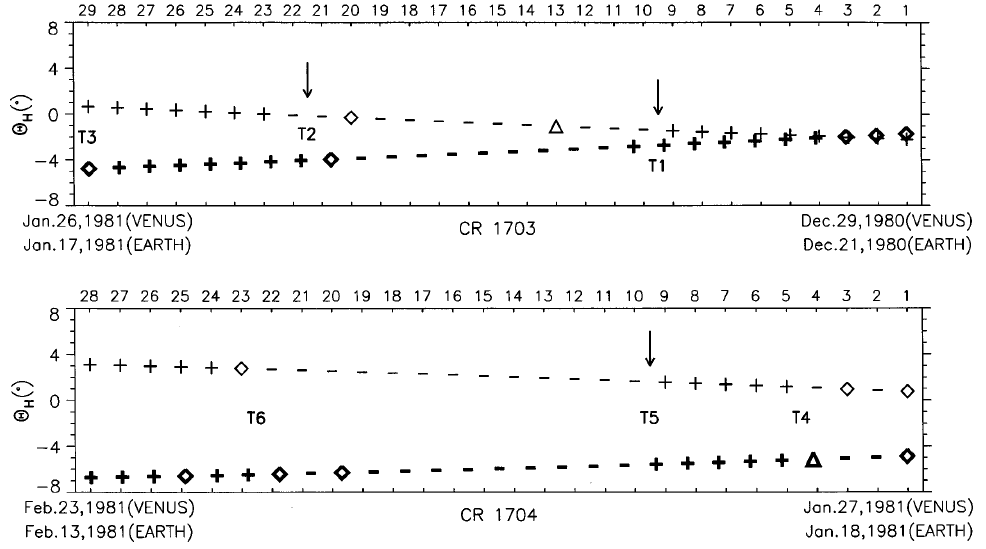
Fig. 1. Daily averages of the IMF polarity observed at Venus ( thin ) and Earth ( thick ) for Carrington rotation (CR) 1703 ( upper panel ) and 1704 ( lower panel ), adjusted for the 4-day and 5-day transit times of